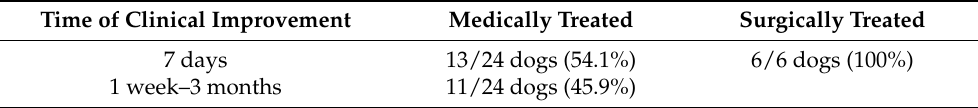
Table 1. Short-term and long-term outcome of 30 dogs conservatively and surgically treated for SEE. Time of Clinical